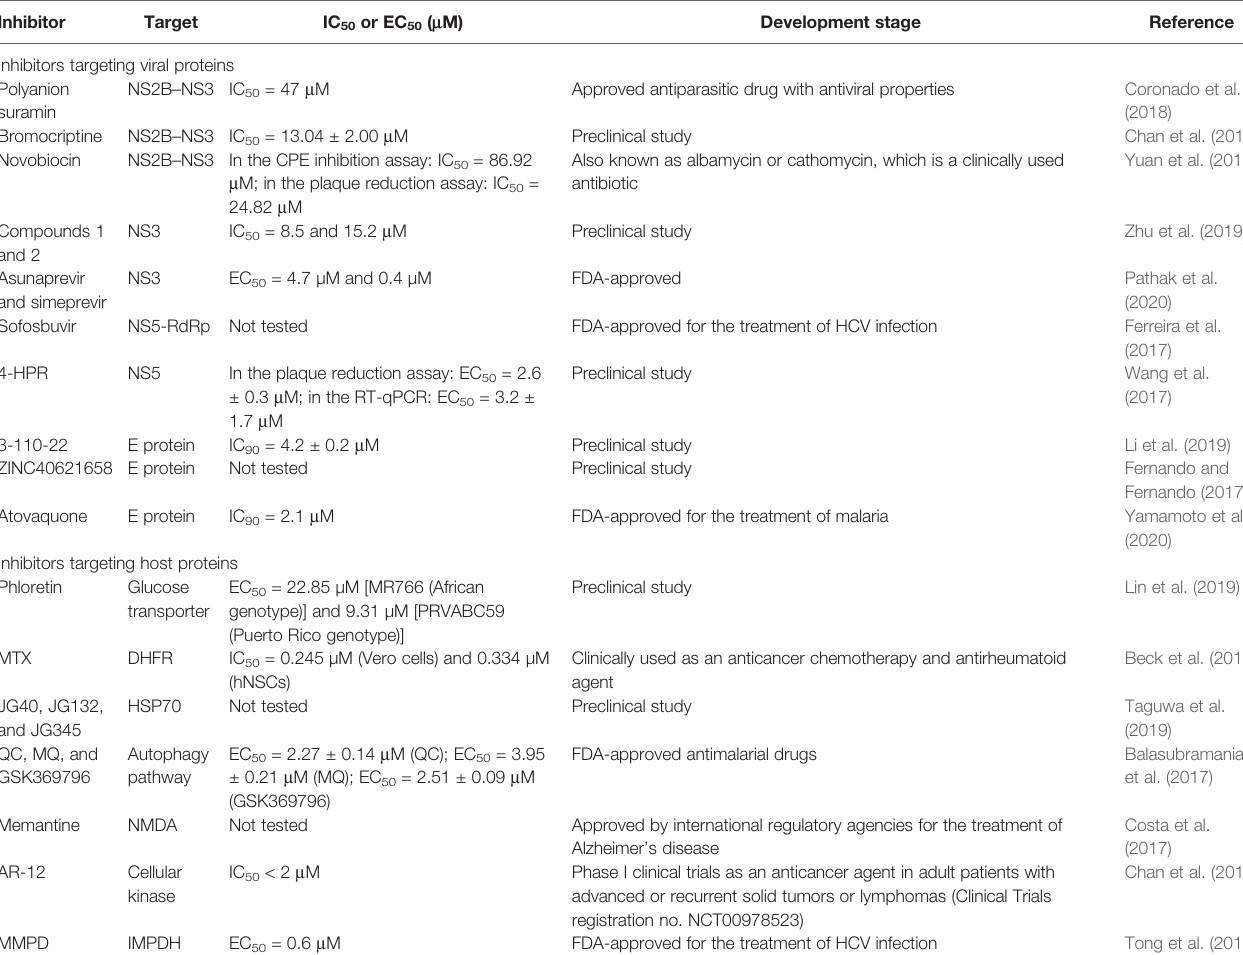
TABLE 1 | Summary of ZIKV inhibitors targeting different viral and host